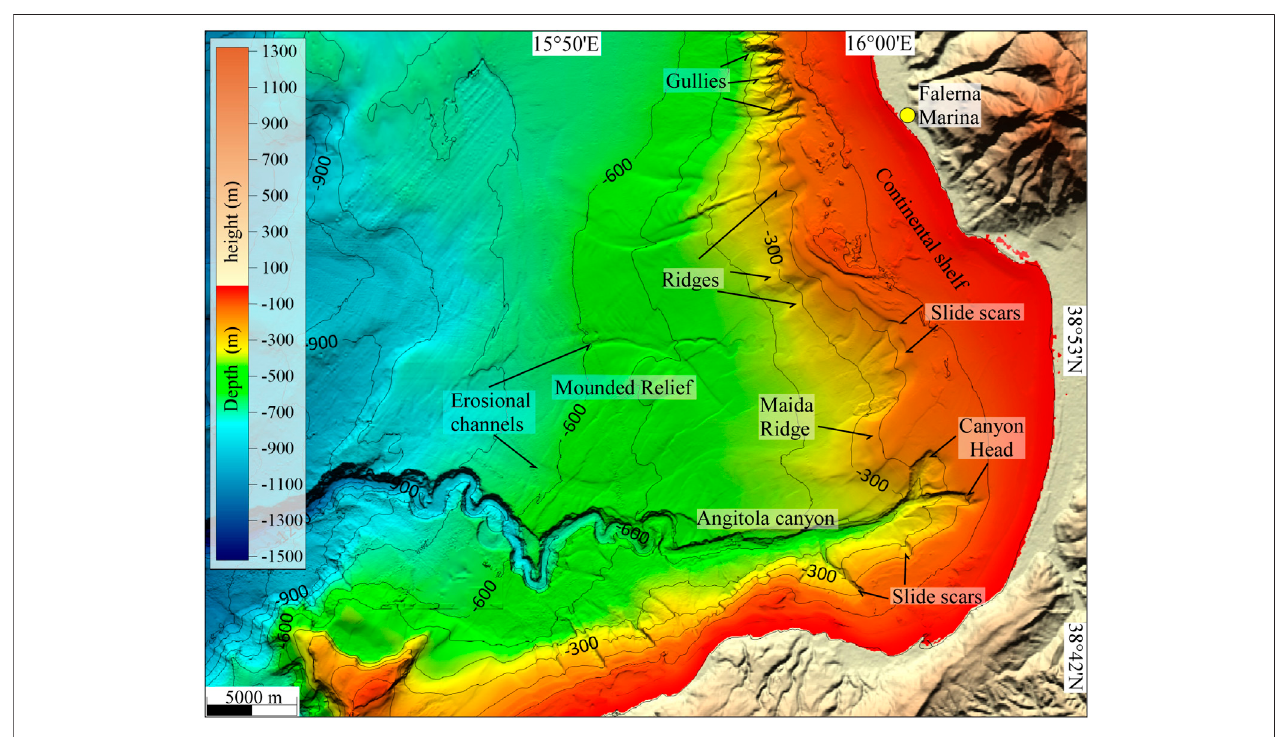
FIGURE 3 | Morphobathymetric map of the Sant ’ Eufemia Gulf.